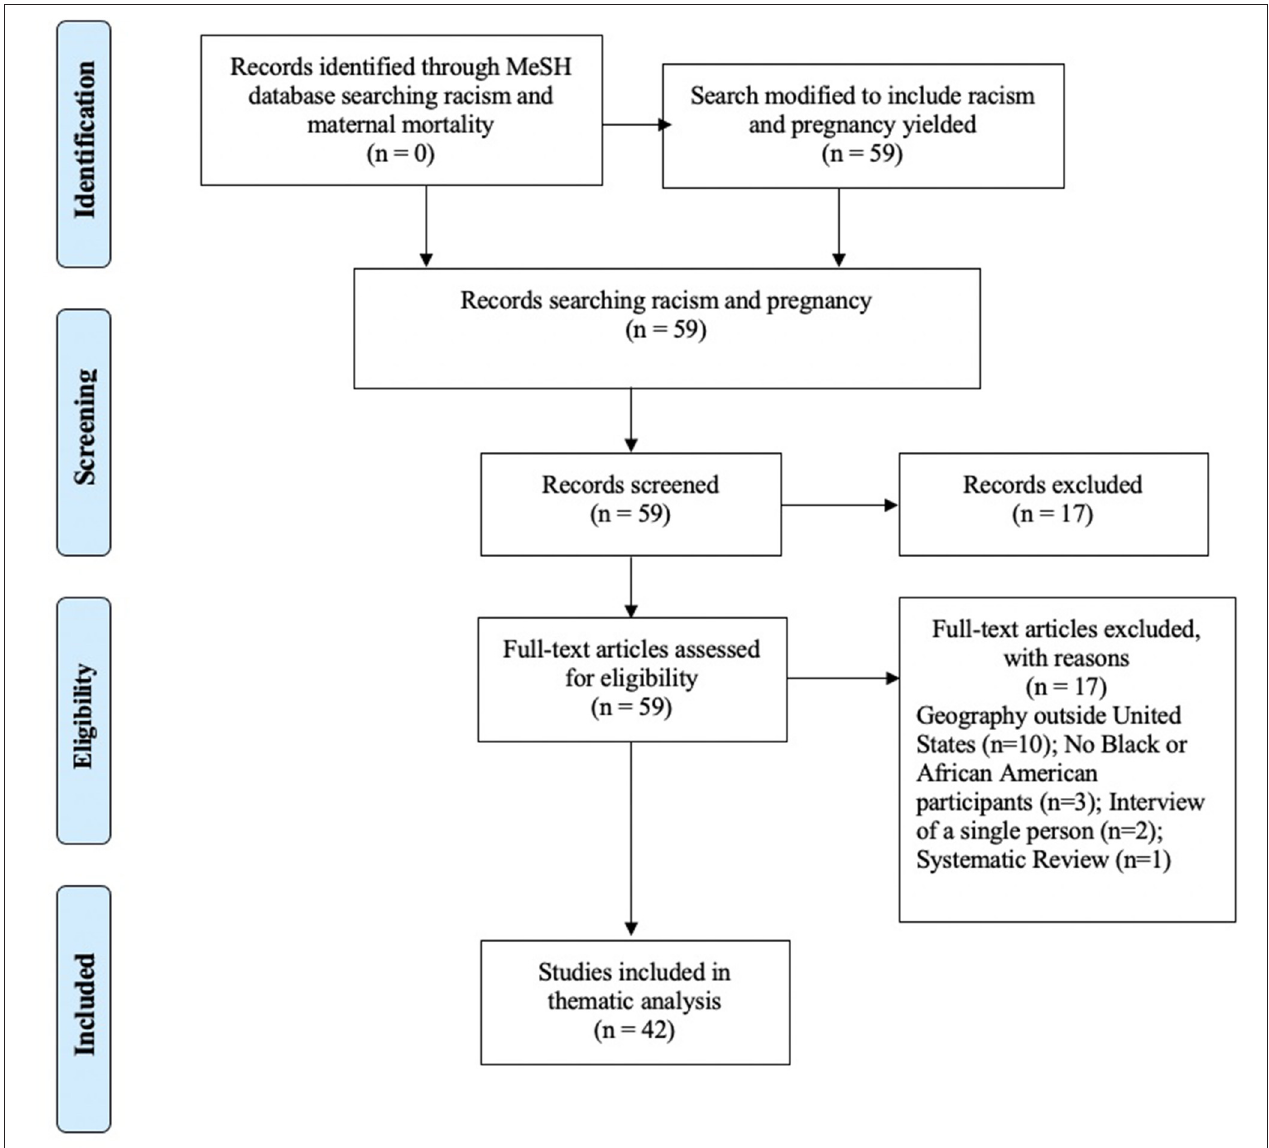
FIGURE 3 | PRISMA for Scoping Review - Phase II - Knowledge